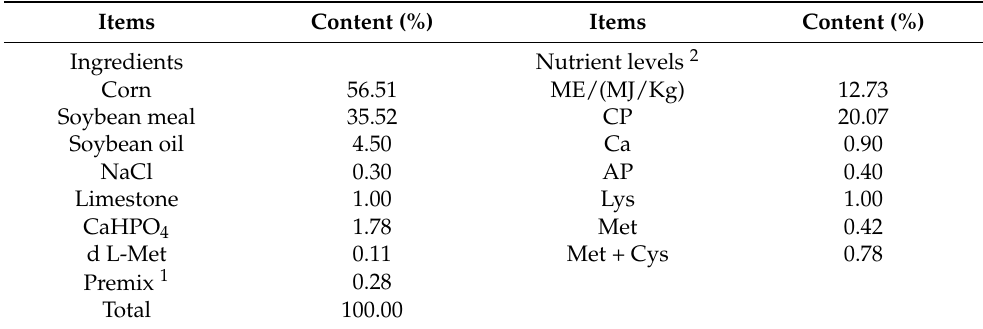
Table 3. Composition and nutrient levels of the basal